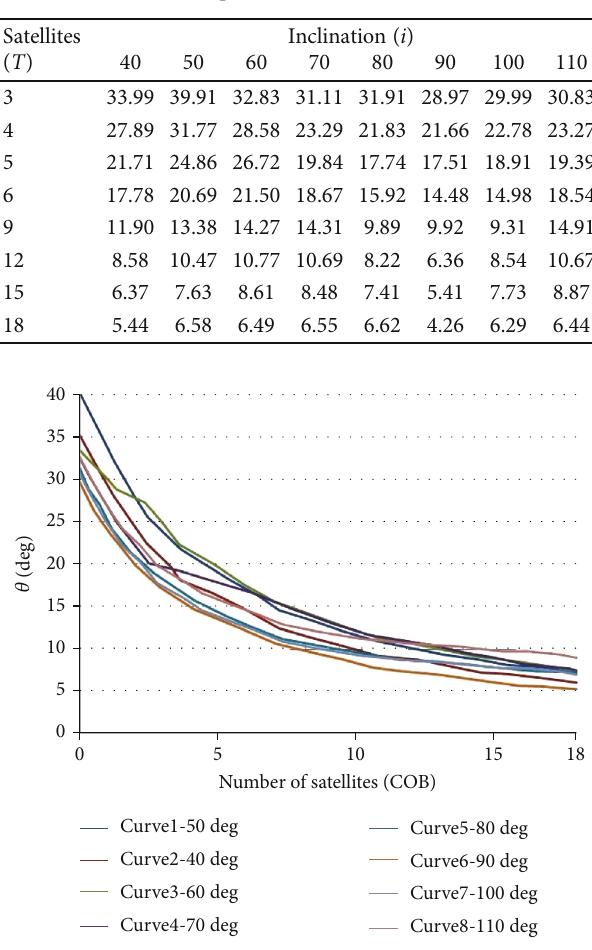
Table 4: θ requirement for the COB method.